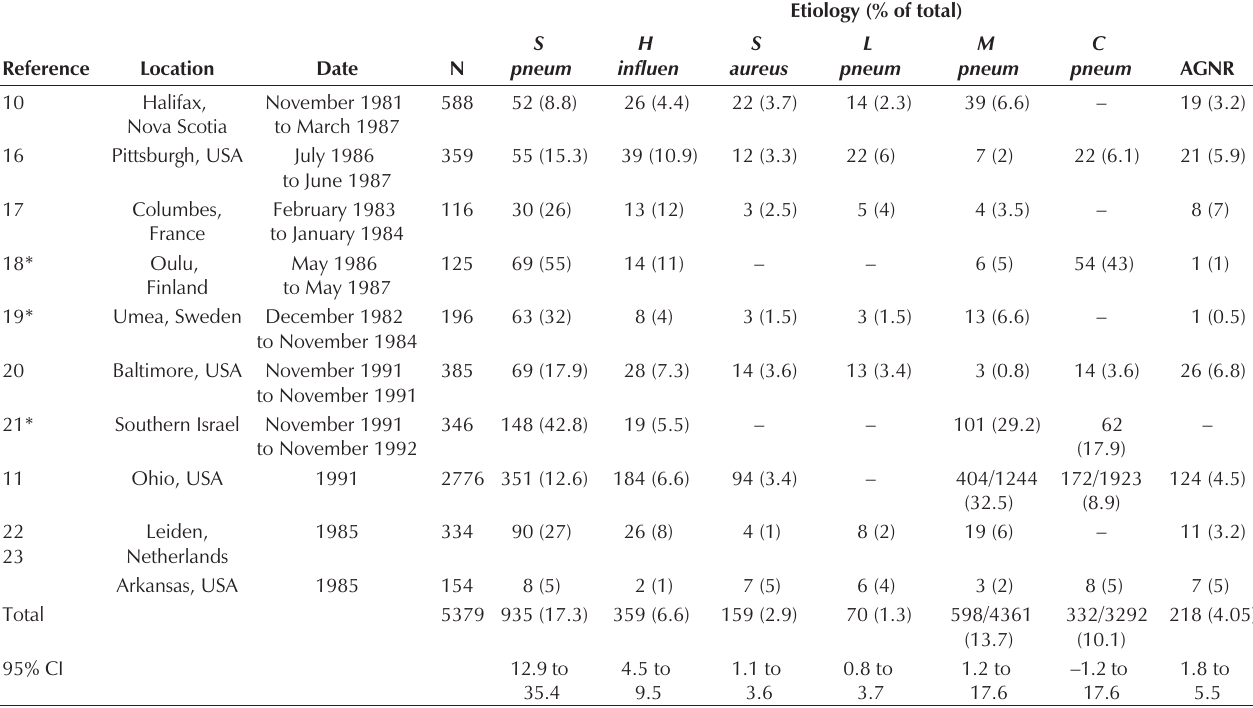
Selected studies showing the etiology of community-acquired pneumonia requiring